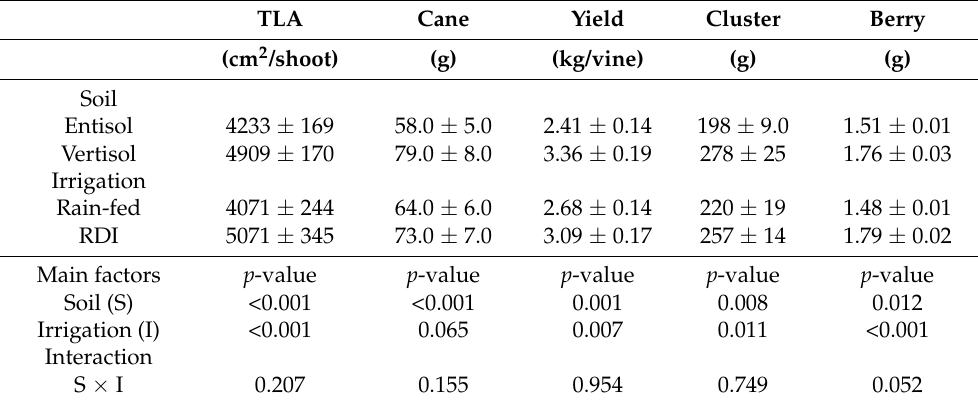
Table 5. Effects of soil and irrigation on vegetative and productive parameters of ‘Nero d’Avola’ grapevines grown in two soils (entisol and vertisol) and under rain-fed and regulated deficit irriga- tion (RDI) treatments. Means ± standard errors and p -values from two-way analysis of variance